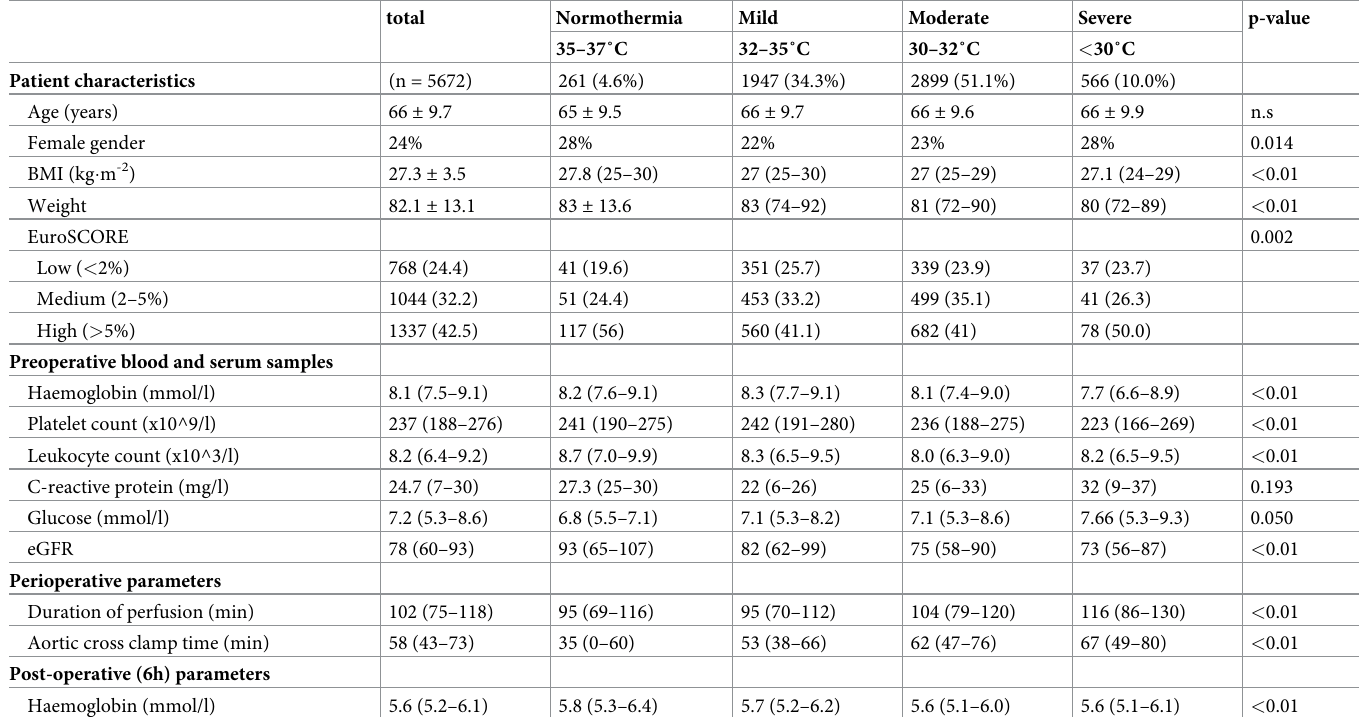
Table 1. Patient characteristics, pre- and perioperative